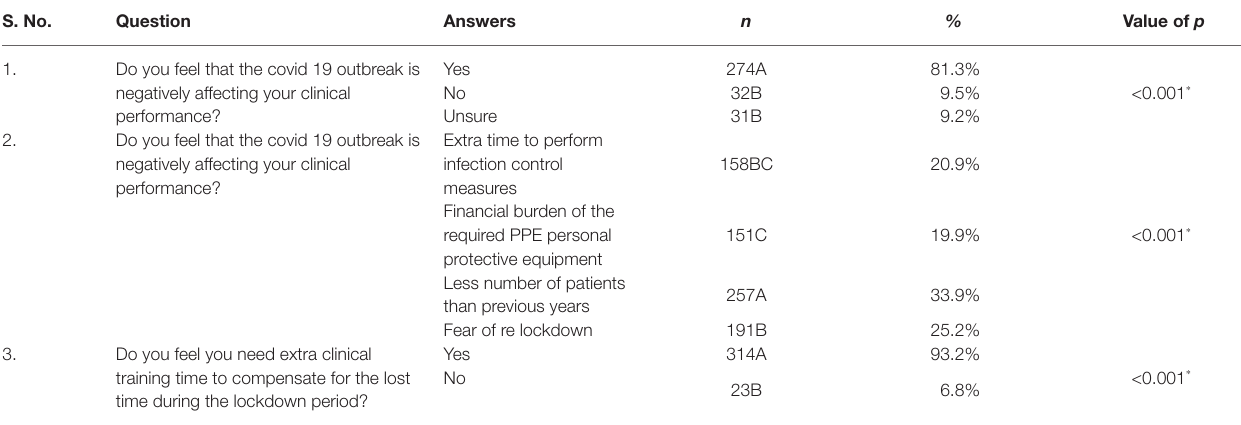
TABLE 3 | Frequency and percentage (%) for answers for assessing the impact of COVID-19 pandemic on the Clinical training of students. S.